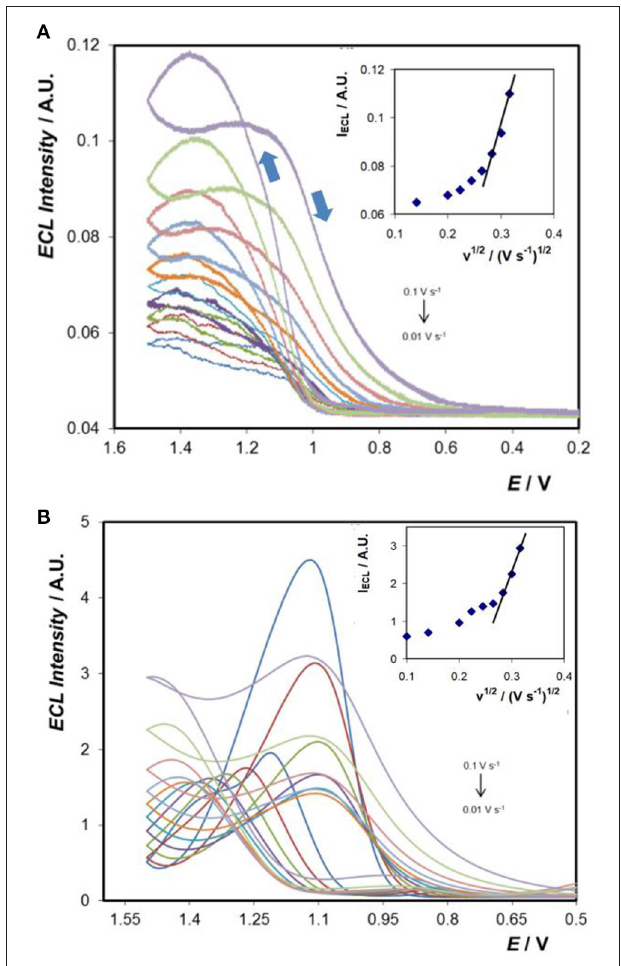
FIGURE 7 | ECL generated at (A) 3D Ti electrode and (B) Au-coated 3D Ti electrode in 0.1M PBS (pH 7.4) solution containing 50 µ M [Ru(bpy) 3 ] 2 + and 5.0mM TPA, at scan rates ranging from 0.01 to 0.1V s − 1 . The insets show the dependence of the maximum ECL intensity on the scan rate for each